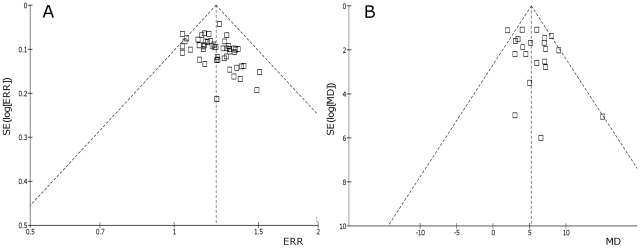
Funnel plots of ERR (A) and LVEF Mean Difference (B).